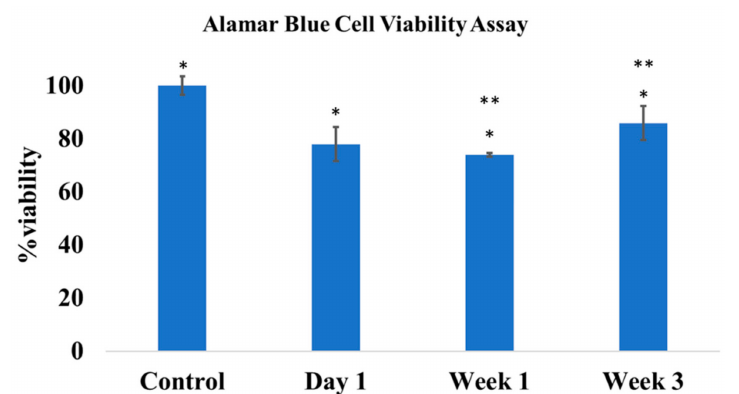
Figure 4. The alamarBlue cell viability assay showed a significant di ff erence in cell viability